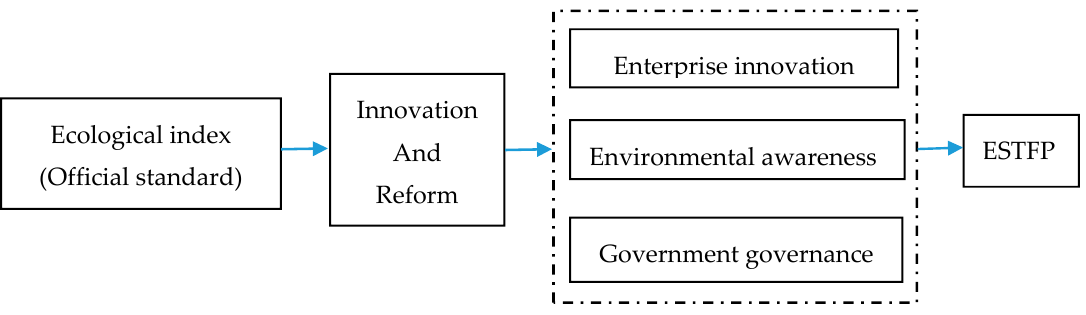
Figure 6. Channels of Influence of the Ecological Index on ESTFP.